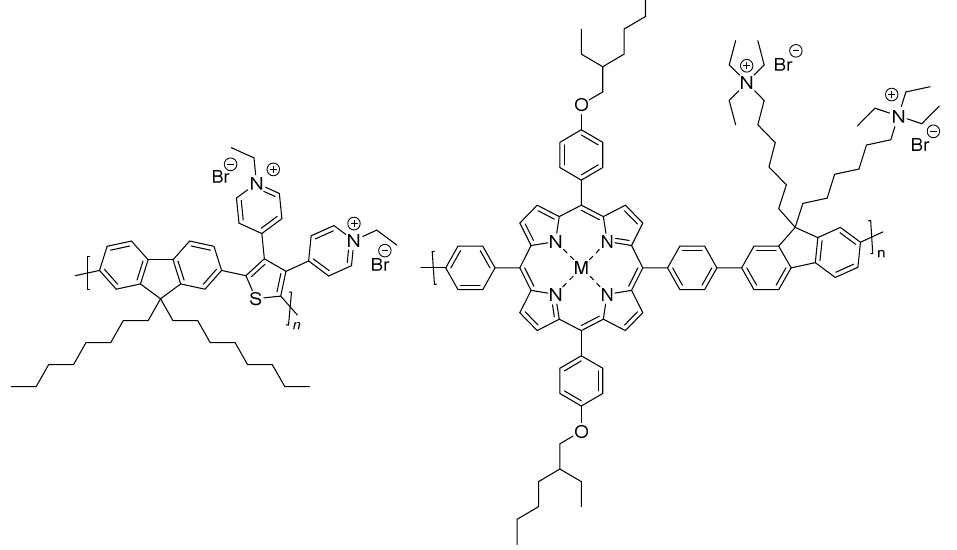
Figure 22. Representative structures of the pyridinium-pended CPE and the porphyrin-based CPE for application in photocatalytic hydrogen production [M = none, Ni, Cu, Pt] [111,112].